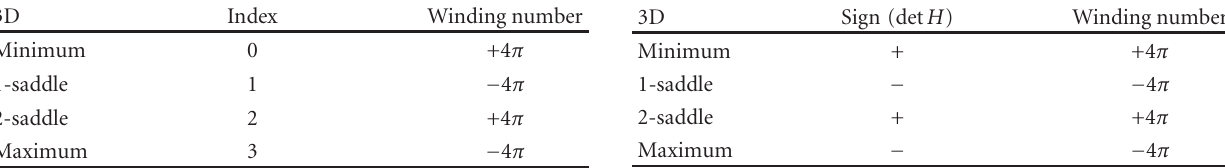
image volumes with a size of 128 × 110 × 180, 138 × 116 × 176, and 180 × 108 × 126 voxels,